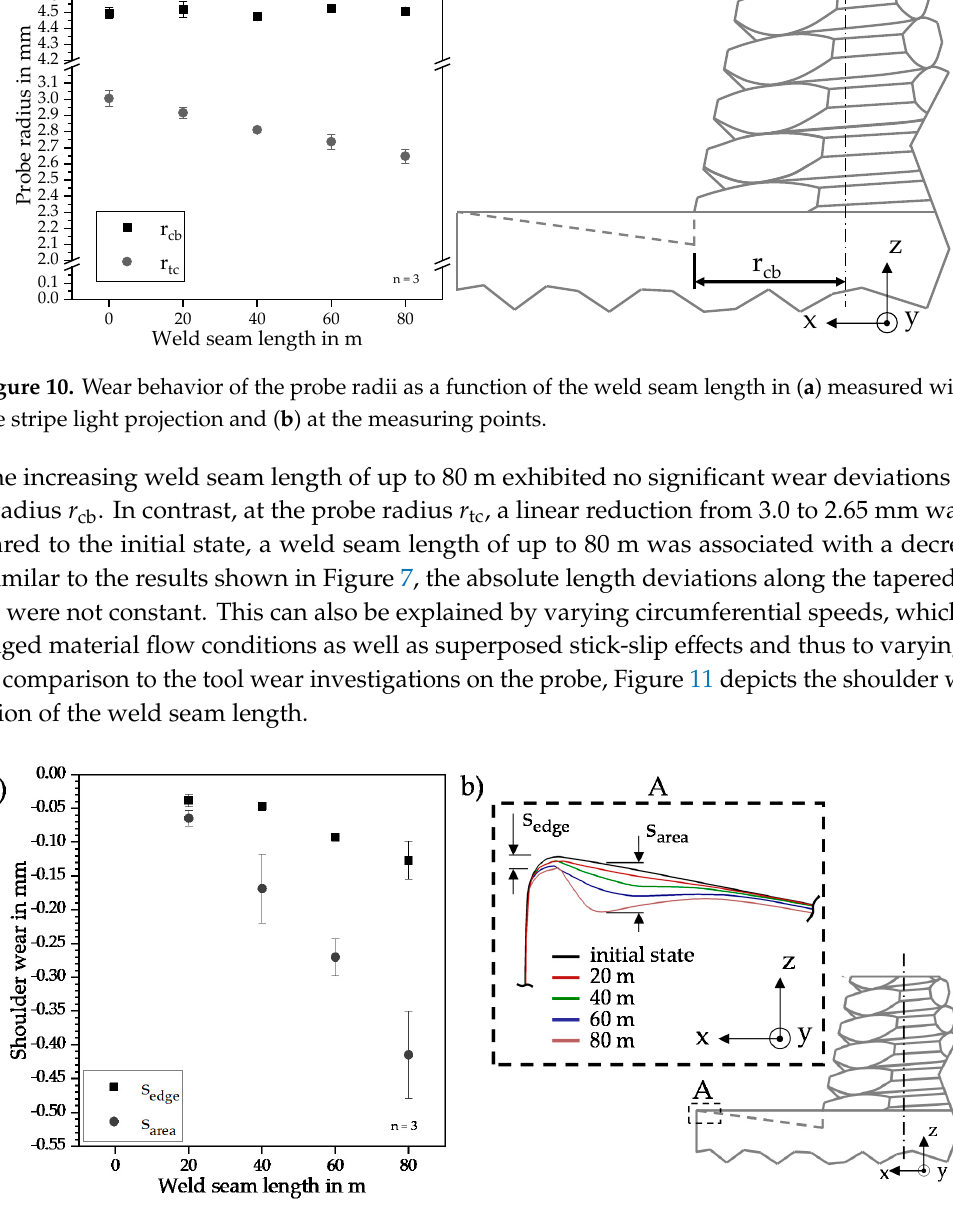
Figure 11. Wear behavior of the shoulder as a function of the weld seam length in ( a ) at the detailed view of the associated measuring points in ( b ).